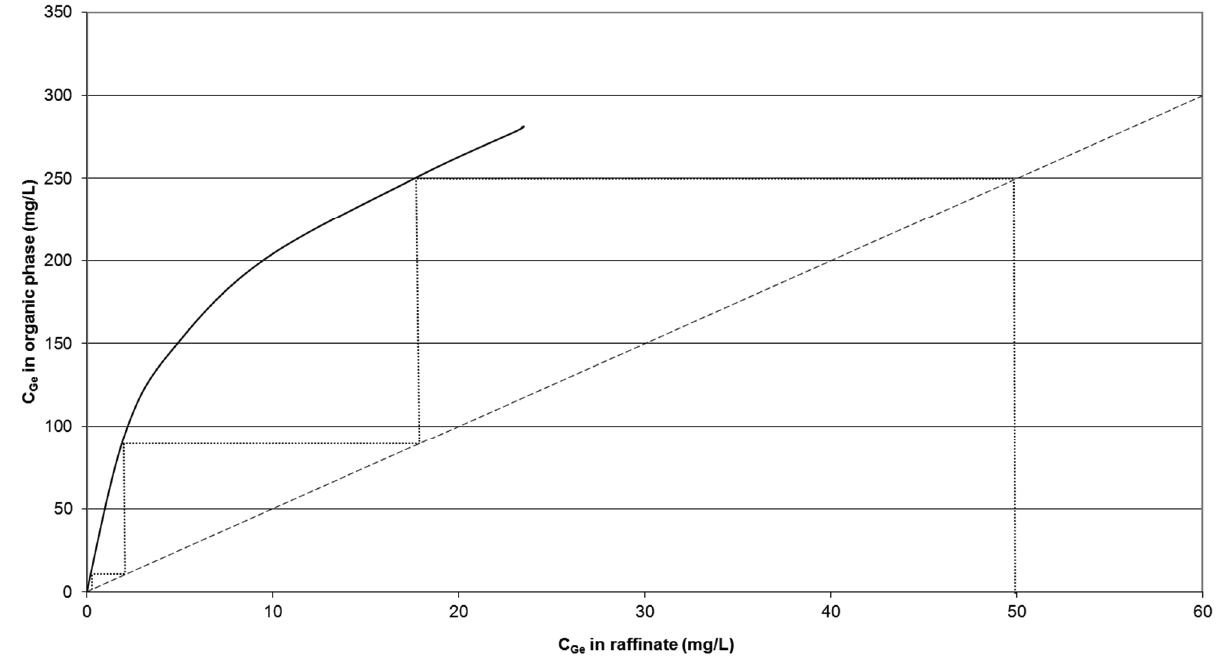
Figure 3. McCabe-Thiele diagram of extraction